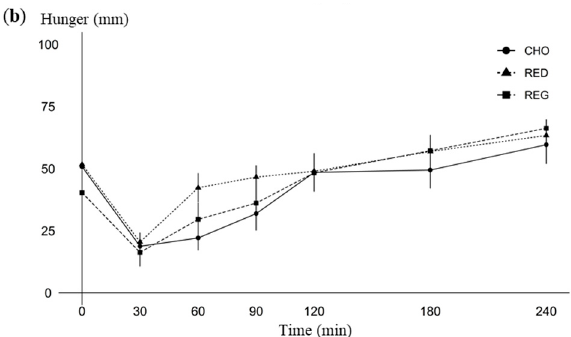
Figure 4. Postprandial appetite sensation of satiety ( n = 37) and hunger ( n = 36). Unadjusted mean ± SEM of satiety ( a ) and hunger ( b ) measured by visual analogue scale. Results were analysed by linear mixed model including a time-meal interaction, time and meal as fixed effects, participant as random effect and adjustments for age, sex, body mass index, fasting value and taste. Neither time-meal interactions nor main effect of meal were significant ( p > 0.05). CHO, carbohydrate-rich meal; RED, reduced ‐ fat cheese; REG, regular ‐ fat cheese.